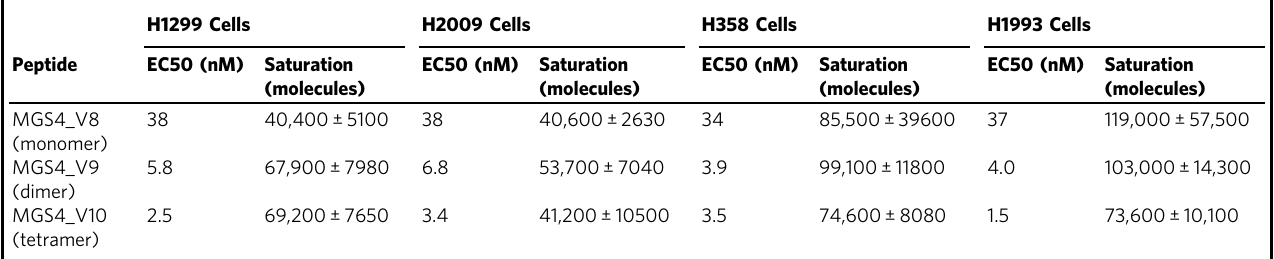
Table 2 EC50 and peptide uptake of MGS4 in different